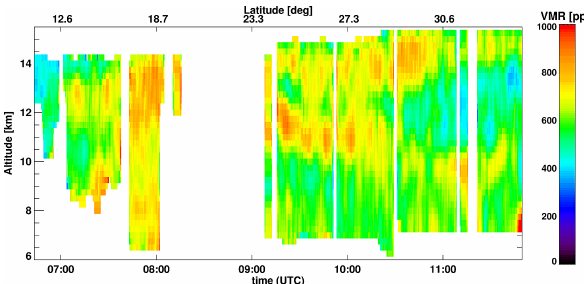
Figure 6. Distribution of ethane (C 2 H 6 ) derived from GLORIA chemistry mode measurements along the track of flight 18 Septem- ber 2012 over the Arabian Sea and the Arabian Peninsula. The en- hancements of ethane point to transport of polluted air into the free troposphere from local sources and suggest, along with trajectory calculations, large-scale advection of polluted air from the monsoon